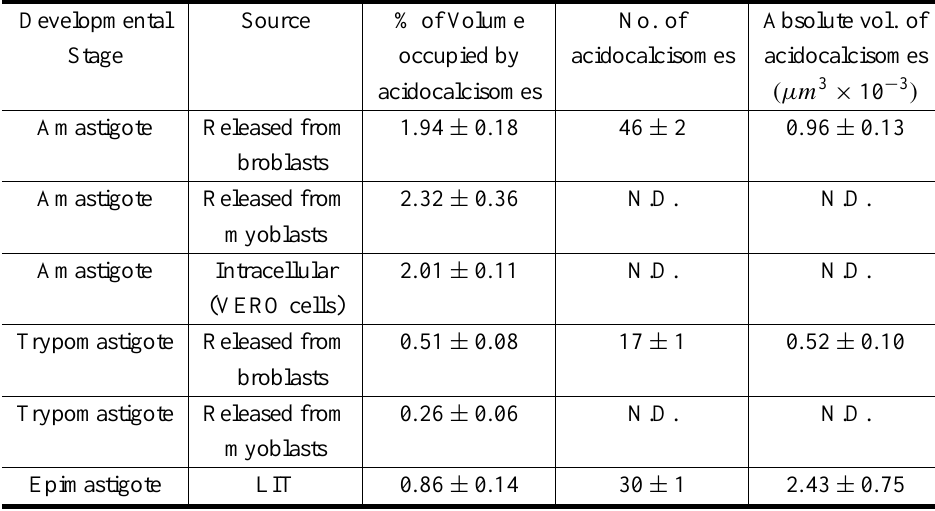
Distribution of acidocalcisomes in Trypanosoma